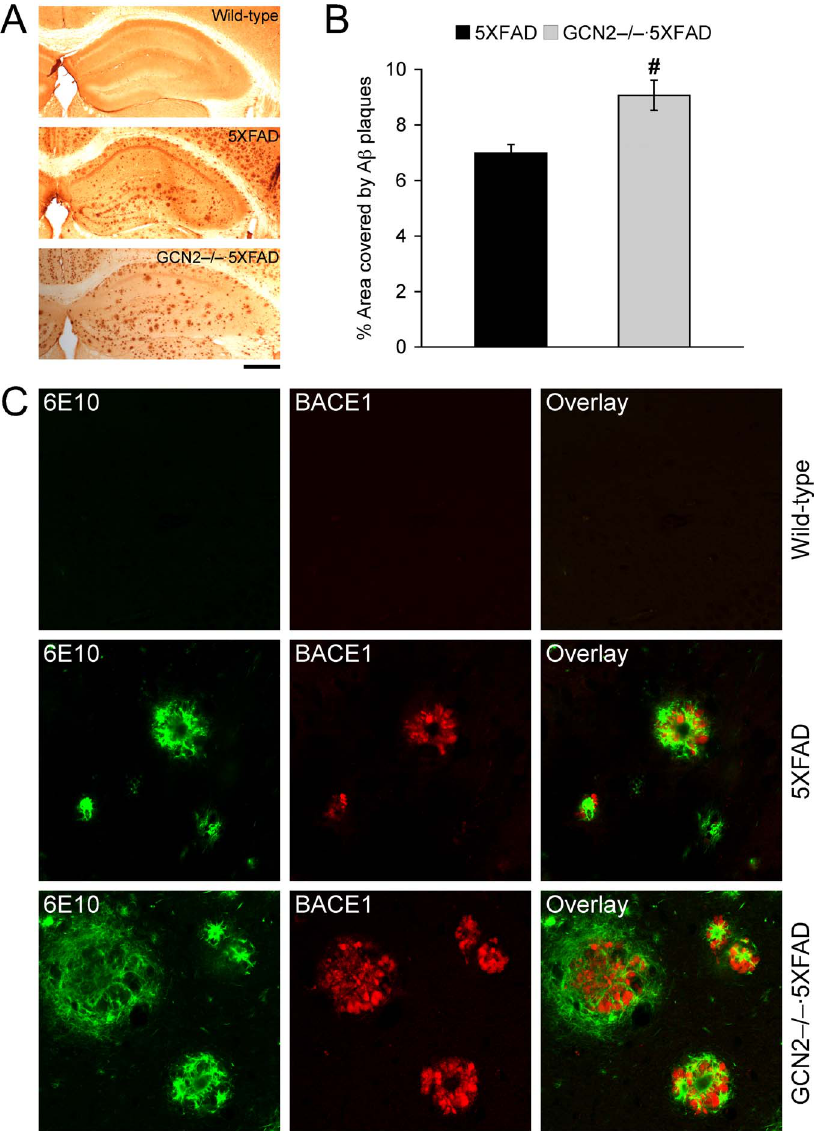
Figure 2. Effects of GCN2 deletion on A b load and plaque-associated elevation of BACE1 expression in 5XFAD mice. (A) Brain sections were immunostained with the 6E10 anti-A b antibody. Shown are representative photomicrographs of the hippocampal region. Scale bar=500 m m. (B) Percentage area occupied by A b deposits in the hippocampus was measured for quantification ( n =6–8). GCN2 2 / 2 deletion exacerbates plaque burden in 5XFAD mice ( # p , 0.05 vs. 5XFAD). Data are presented as mean 6 SEM. (C) Double immunofluorescence labeling with 6E10 anti-A b (green) and anti-BACE1 (red) antibodies ( n =3–4). Note the high degree of colocalization of A b and BACE1 immunoreactivities in the hippocampus of 5XFAD and GCN2 2 / 2 ? 5XFAD mice. Scale bar=50 m